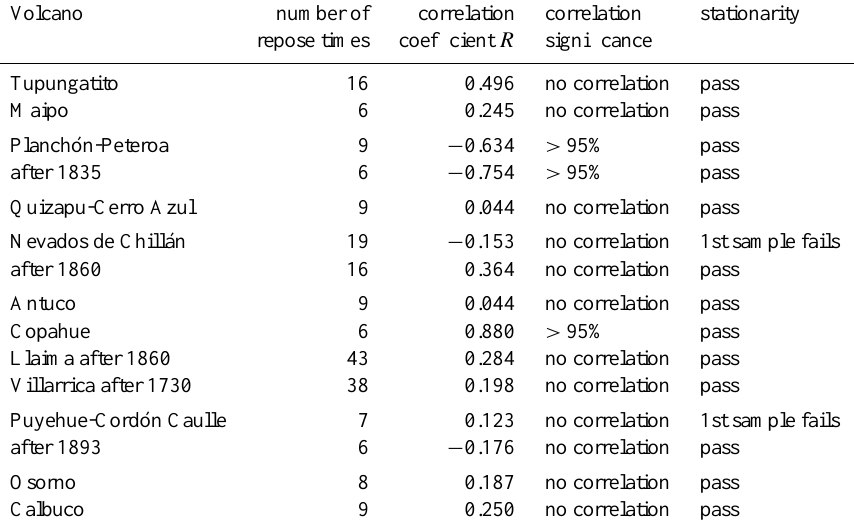
Table 1. Results for the correlation and stationarity check for the SVZ volcanoes. The columns show the number of repose times between the eruptions in the record, the correlation coefficient R derived from the scatter plots, and the significance of the correlation measured by the correlation coefficient R . Where no correlation was found at 95% significance, “no correlation” is stated. The last column gives the result of the statistical stationarity check from the moving average plots, stating either that the data passed the stationarity check, or at which data points the acceptable scatter was exceeded. Where a volcano failed in one of the tests, it was examined whether restricting the record to later times would improve the results. Only volcanoes which passed both tests and still contained a sufficient amount of data entries were included in the later analyses. A visual impression can be derived from Fig. 2 and from the plots in the supplementary material.